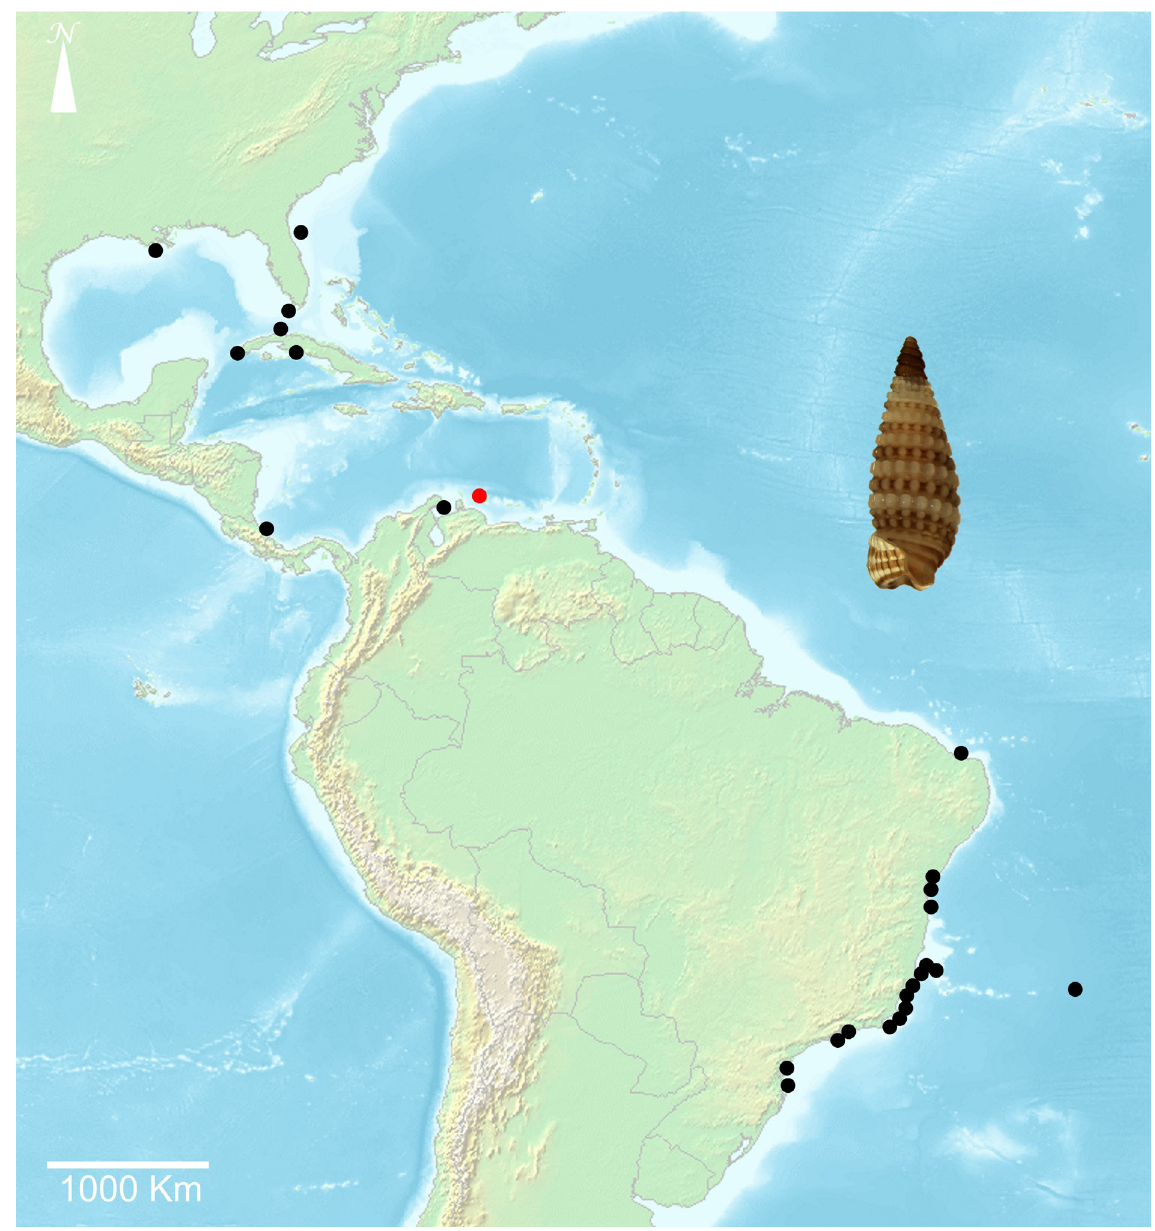
Fig. 78. Distribution map of Triphora ellyae De Jong & Coomans, 1988; red circle = type